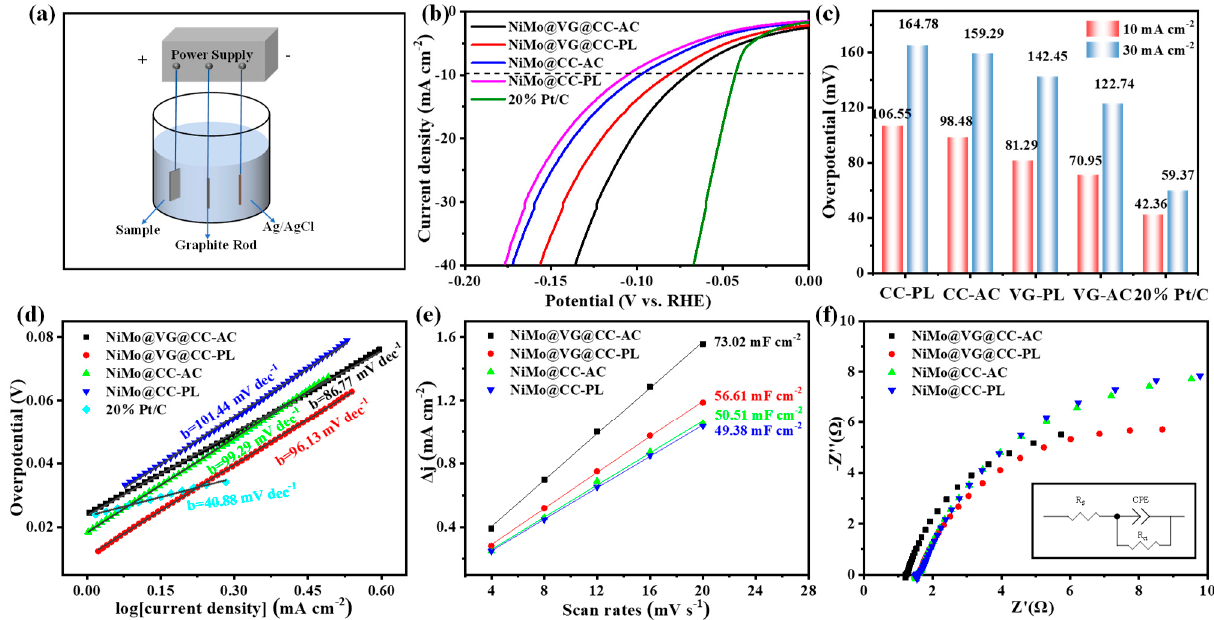
Figure 3. Electrochemical performance of composite catalysts in 1 M KOH electrolyte. ( a ) Three- electrode set; ( b ) HER polarization curves; ( c ) Comparison of overpotential at the 10 mA cm − 2 and 30 mA cm − 2 ; ( d ) Corresponding Tafel plots; ( e ) Calculated double layer capacitance (C dl ) values; ( f ) Nyquist plots at the overpotential of 80 mV.